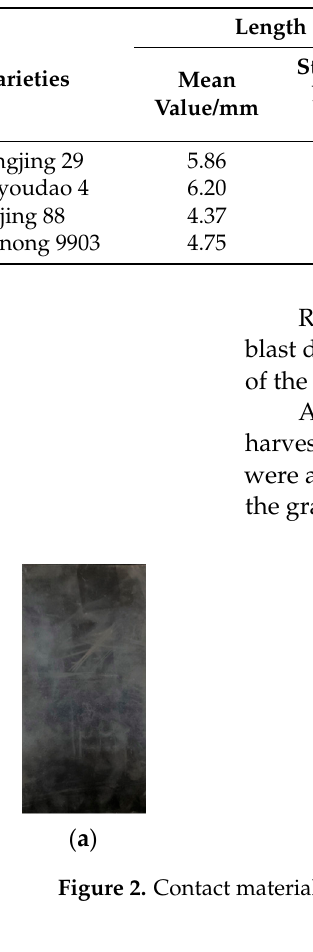
Table 1. The main parameters of typical rice varieties.